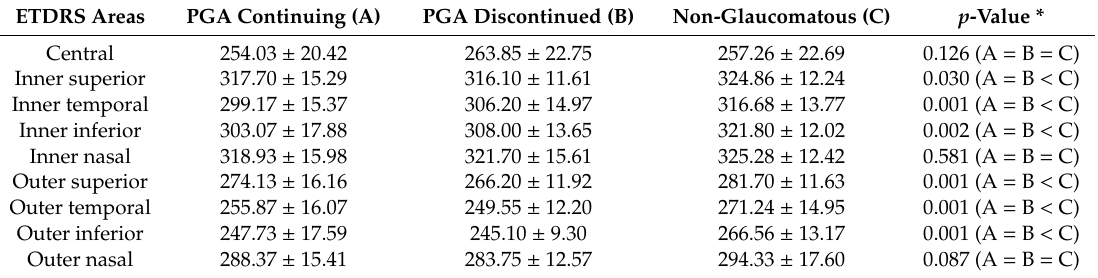
Table 3. Comparison of postoperative macular thicknesses among the PGA continuing, PGA discontinued, and non-glaucomatous groups.